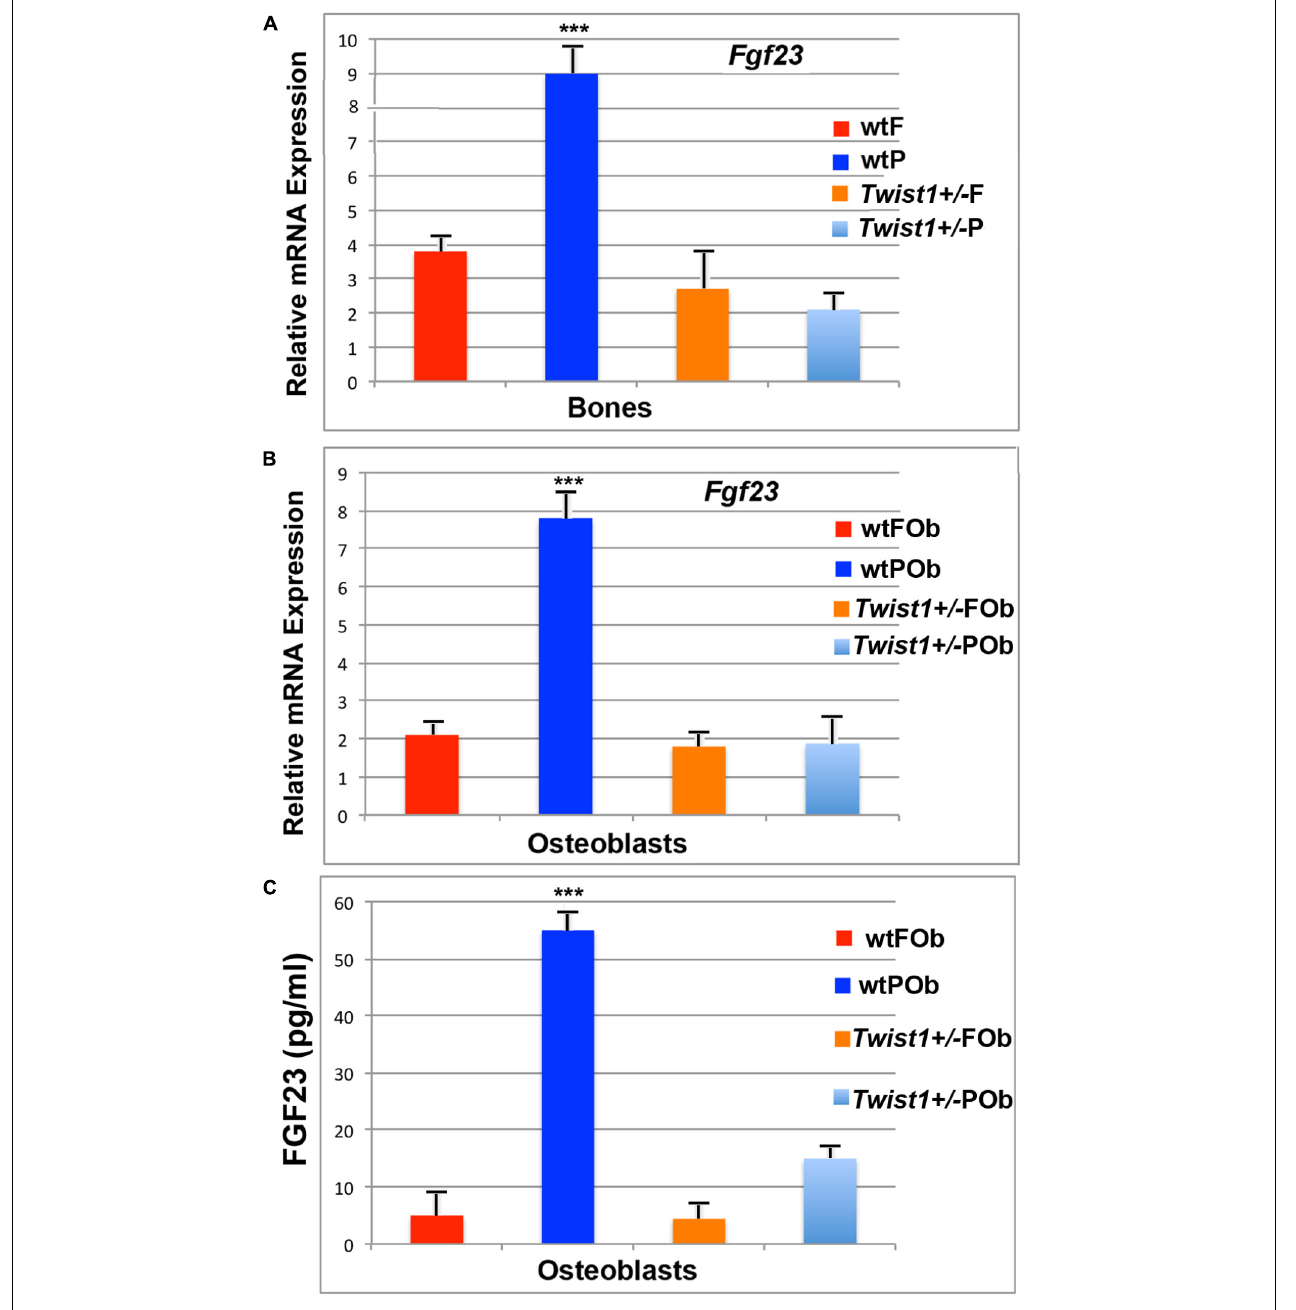
FIGURE 4 | Validation of Fgf23 in calvarial bones and derived osteoblasts. (A) Validation of Fgf23 downregulation obtained by performing PCR analysis on bone tissues. (B) RT-qPCR analysis showing Fgf23 down-regulation in osteoblast primary cultures (depleted of pericranium and dura mater- derived cells). (C) ELISA assay performed on media collected from osteoblast cells and concentrated by 20-fold. Elevated level of secreted FGF23 protein is detected in the medium of wild-type POb, whereas in Twist + / − POb protein levels are sharply decreased to values similar to that of wild-type and Twist + / − FOb. Value: ∗∗∗ p ≤